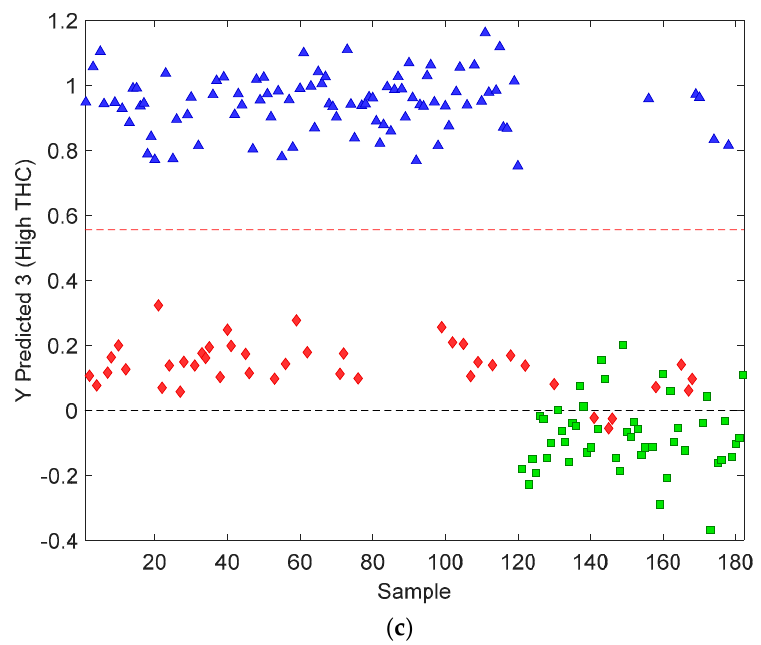
Figure 3. The classification of ( a ) even-ratio; ( b ) high-CBDA; and ( c ) high-THCA classes using the VIAVI MicroNIR OnsiteW instrument. Table 2. Calibration and validation values of partial least square discriminant analysis (PLS-DA) models on the ratio of cannabinoid compounds analysed by the Bruker MPA II